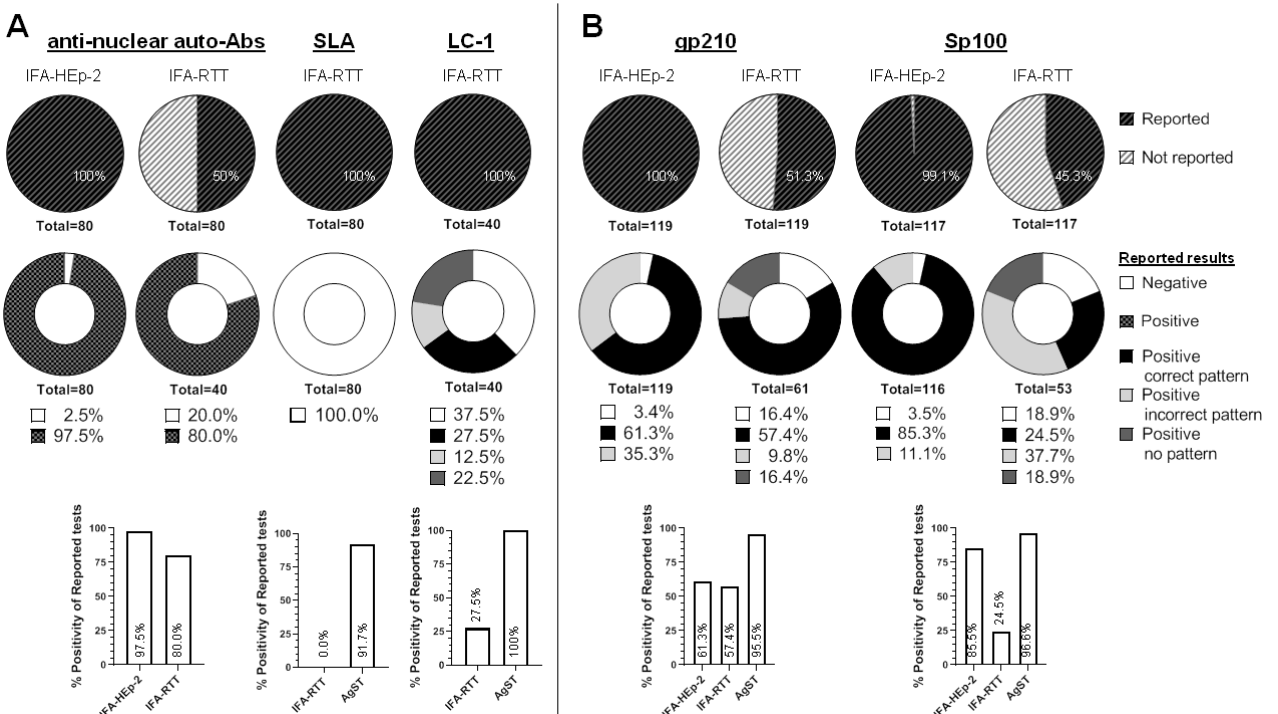
Figure 3. Summary of results obtained for associated anti-nuclear, anti-SLA and LC-1 autoantibodies. Results were obtained for each AIH- ( A ) and PBC- ( B ) associated autoantibody specificity employing IFA and/or AgST. Abbreviations: AgST, antigen-specific techniques; gp210, glycoprotein 210;